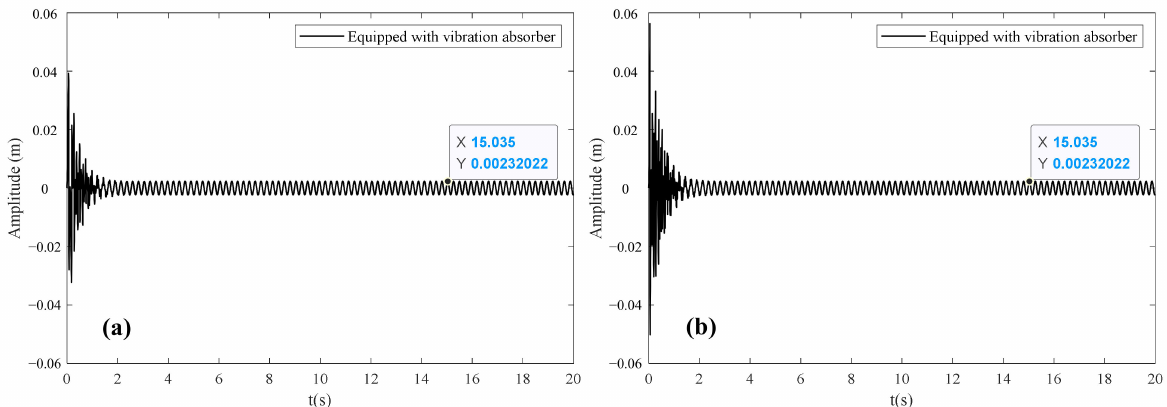
Figure 5. Saturation amplitude under different external excitation amplitudes: ( a ) the external excitations amplitude F 0 = 0.05 N; ( b ) the external excitations amplitude F 0 = 0.1